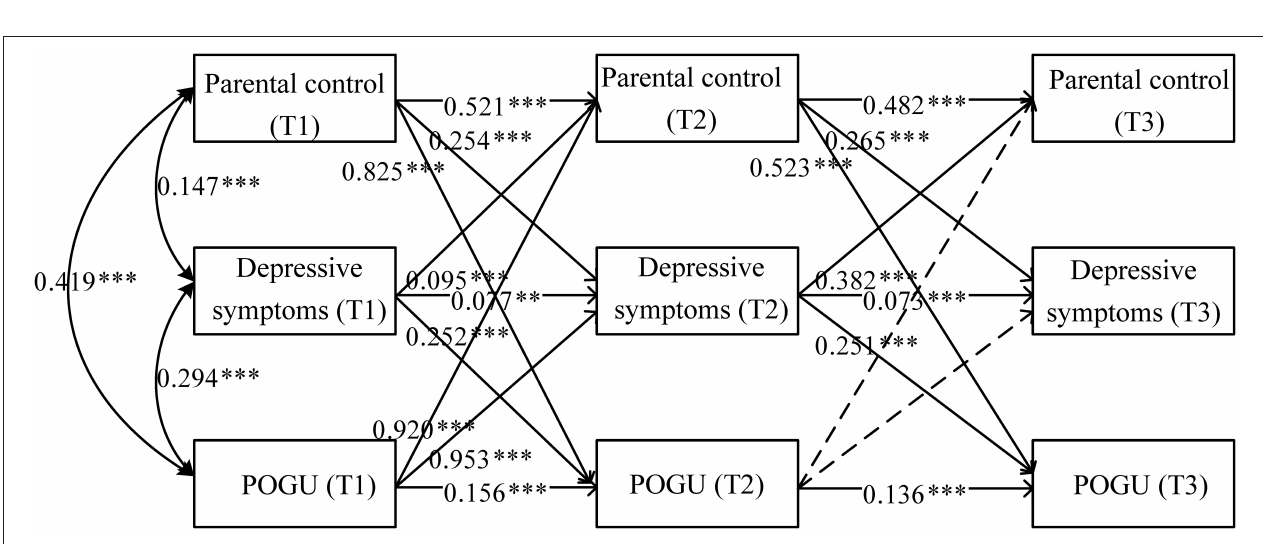
parental control (e.g., rejection, overprotection), depressive symptoms, and problematic online game use. Girls